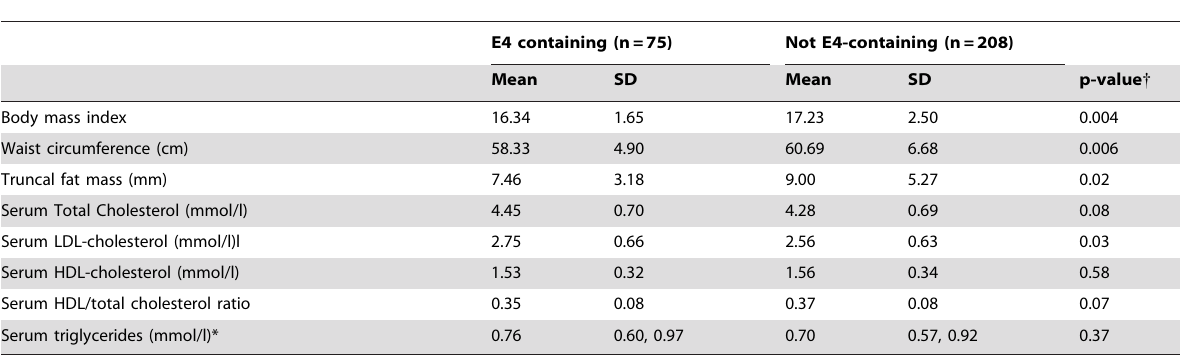
Table 2. Lipid and body size characteristics in E4-containing and Not E4-containing APOE genotype